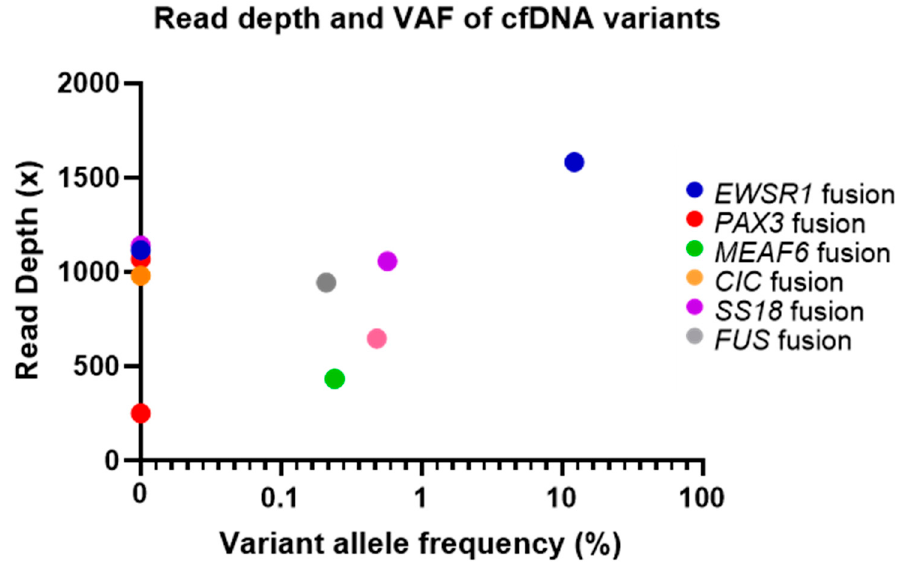
Figure 1. Fusion genes detected and estimated VAF (%) for each circulating tumour DNA (ctDNA)